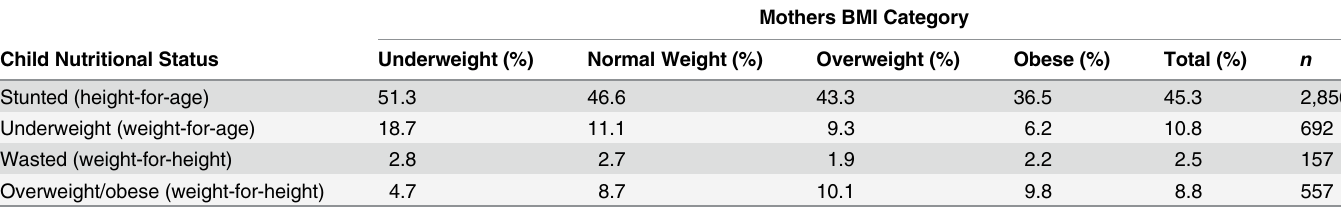
Table 2. Coexistence of under- and over-nutrition in the same household, Nairobi